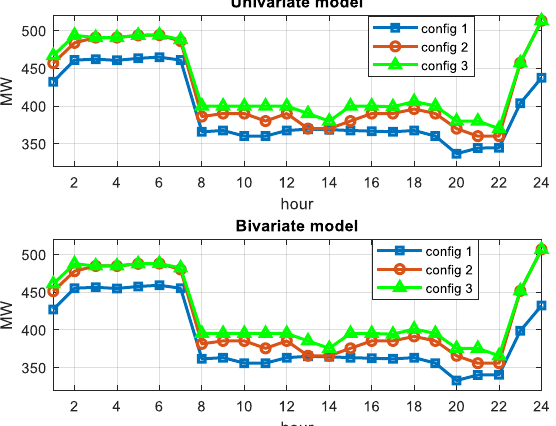
Figure 10. Spinning reserve allocation under different system configurations calculated using univariate and bivariate wind prediction models.